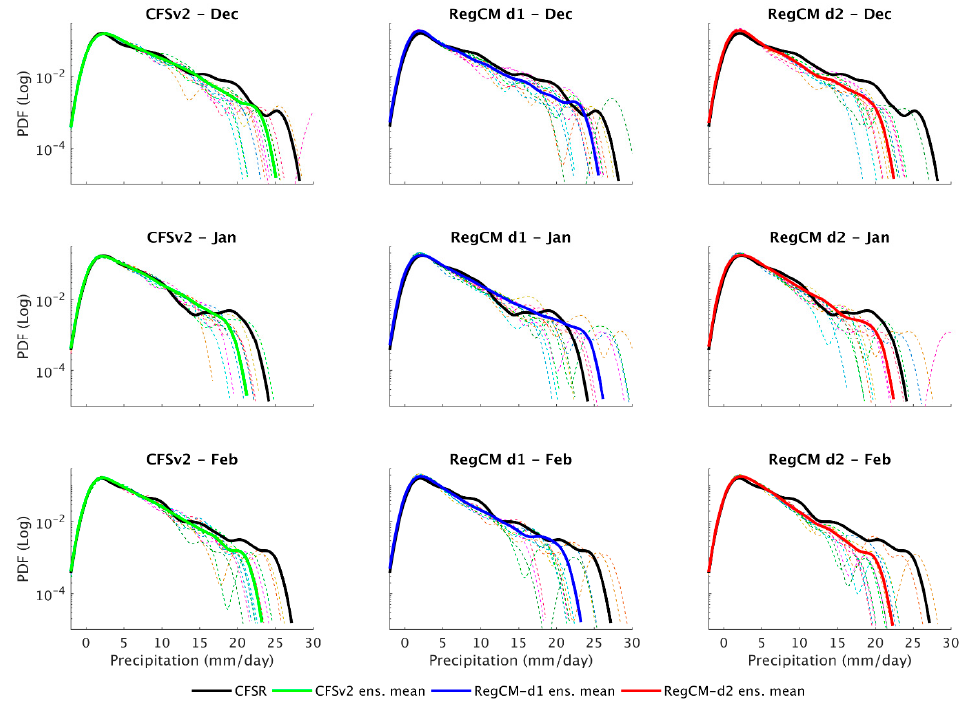
Figure 10. The same as in Figure 3 but for the precipitation.